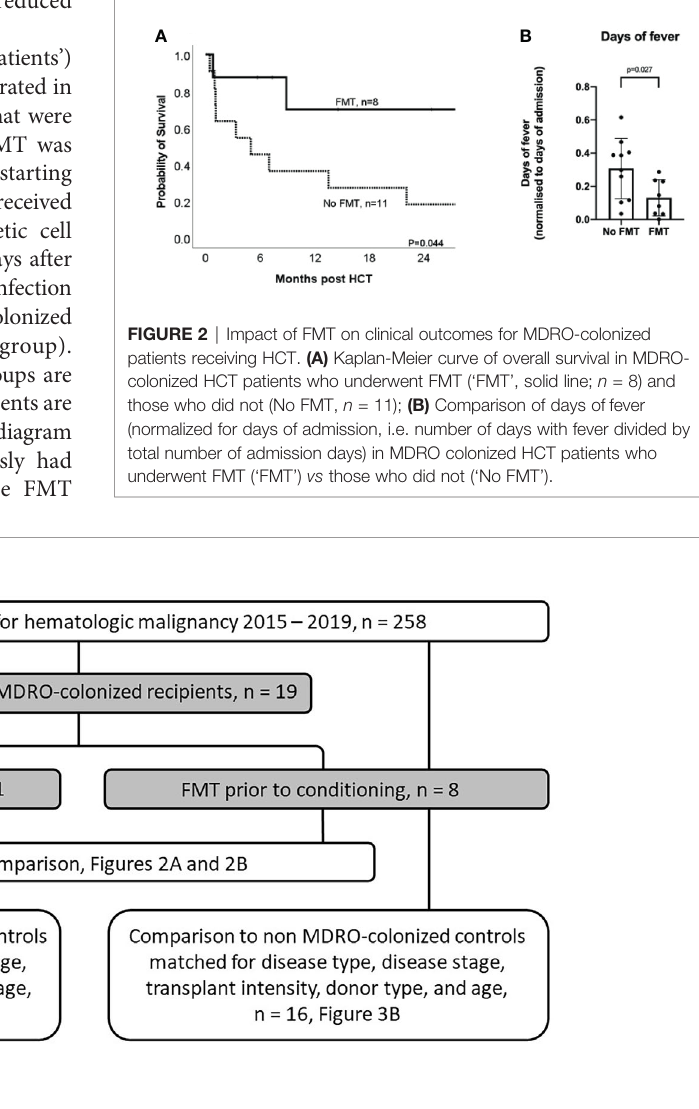
FIGURE 1 | CONSORT diagram.